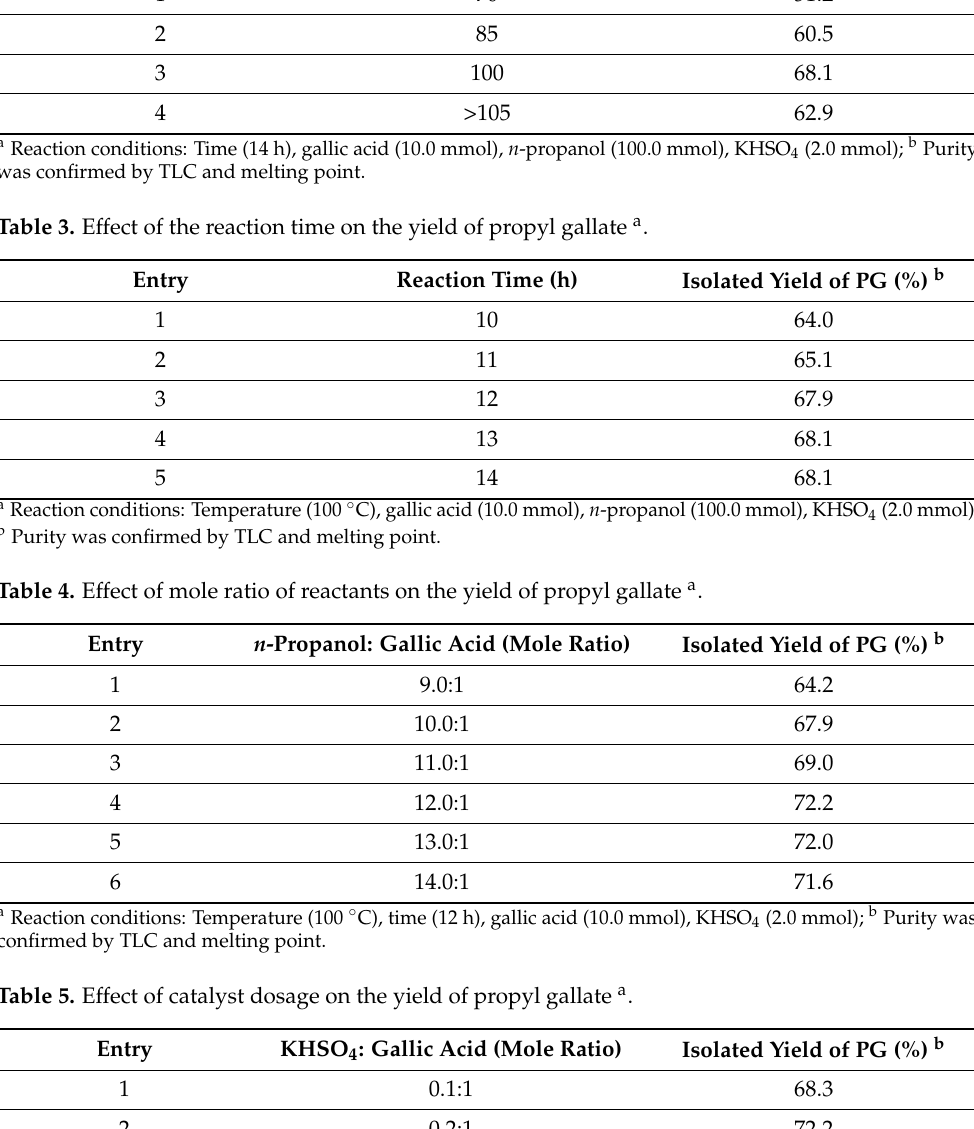
Table 5. Effect of catalyst dosage on the yield of propyl gallate a .